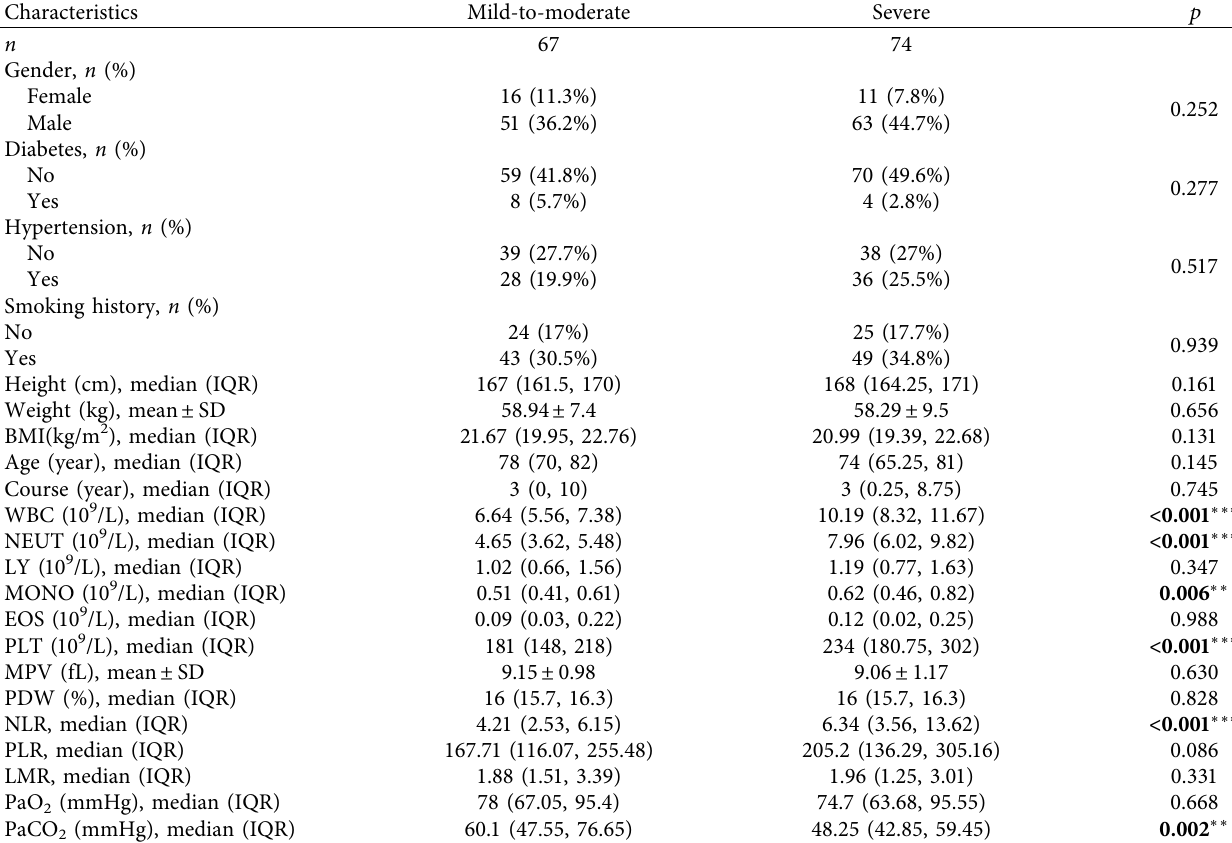
Table 1: Comparison of clinical characteristics between the mild-to-moderate group and the severe group in COPD patients.